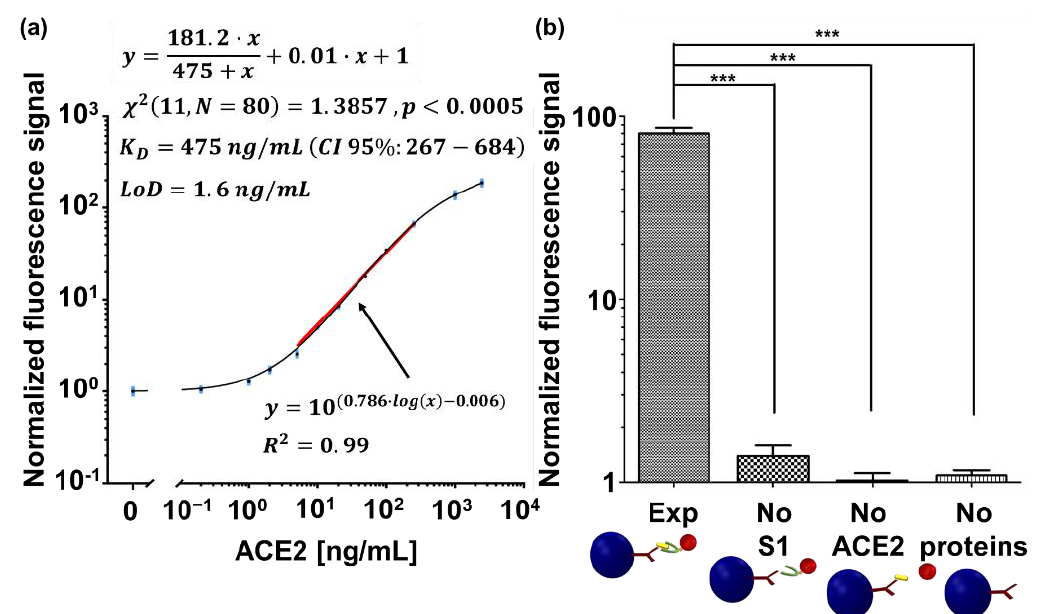
Figure 3. Detection of the S1-ACE2 interaction. ( a ) A dose response curve of S1 interaction with ACE2, measured by MMB. All measurements were normalized to the average signal of the conjugated beads. Using all the replicates, the curve was fitted to one site-total binding model. The extracted K D is reported as K D (CI 95%: lower limit–upper limit). The chi-square Goodness of fit is reported as χ 2 (degrees of freedom, sample size). The solid red line was fitted using a non-linear regression analysis to the log-log dose response curve, and it represents the analytical sensitivity of the assay. Error bars (in blue) represent the standard error of the mean (SEM) of blank measurements ( n = 5) and all other concentrations (5 ≤ n ≤ 8 ) . ( b ) Negative controls to the dose response. Abbreviations: “Exp”, conjugated magnetic beads with the attached S1 protein are introduced to 250 ng/mL ACE2 protein and SA-PE. “No S1”, conjugated magnetic beads without the attached S1 protein are introduced to 250 ng/mL ACE2 and SA-PE. “No ACE2”, conjugated magnetic beads with the attached S1 protein are introduced to SA-PE. “No proteins”, conjugated magnetic beads are introduced to SA-PE. Three asterisks (***) indicate a statistical significance of p < 0.001. All measurements were normalized to the signal of the conjugated magnetic beads. The normalized fluorescence signal values are presented as the mean ± SEM.